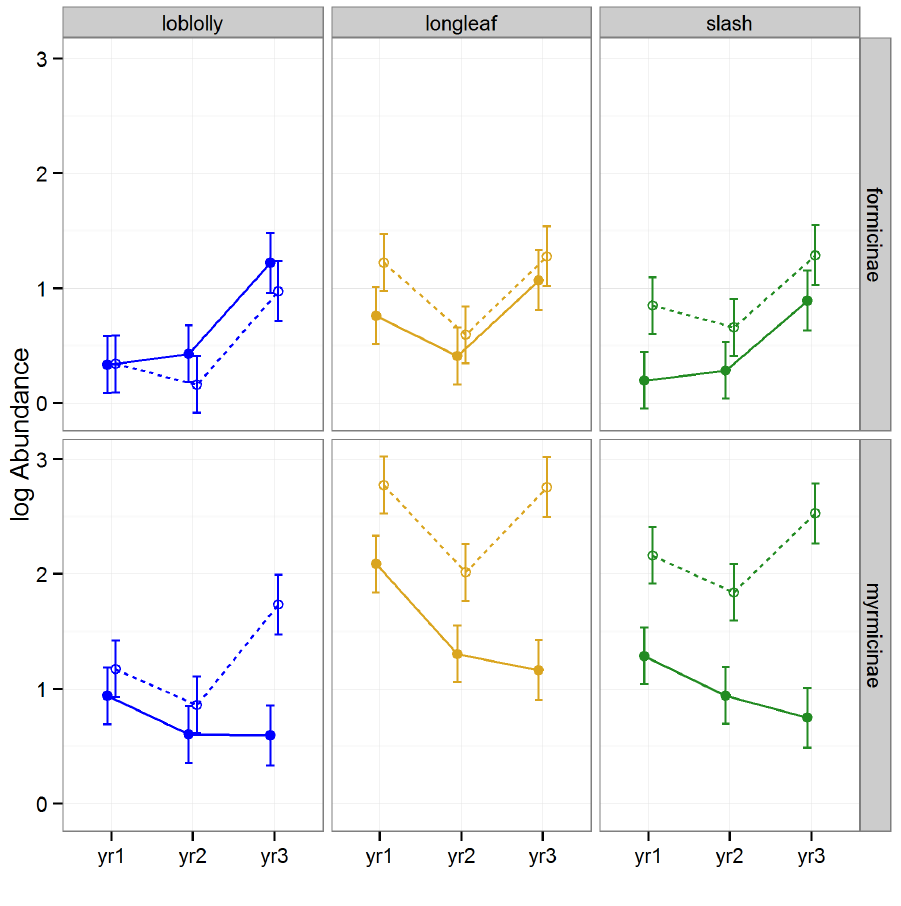
Figure 6. Predicted means and standard errors of Hymenoptera abundance (log transformed) during three years of seasonal pitfall trapping in pine plantations in North Florida against fixed effects from the most parsimonious model based on log-likelihood ratio tests; raked stands are displayed with open circles and dashed lines, intact stands with solid circles and lines; 2008 as yr1, 2009 as yr2 and 2010 as